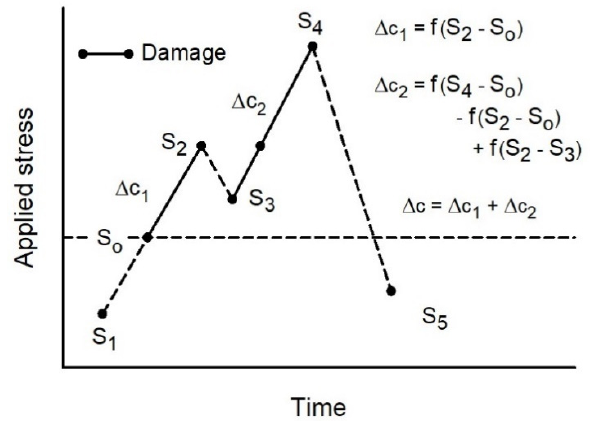
Figure 2. Damage calculations using crack-closure theory under variable-amplitude loading.